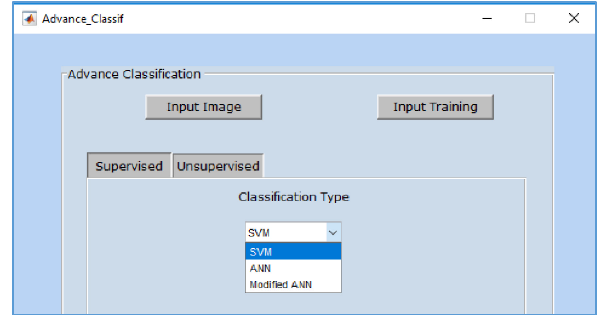
Figure 11. The interface of the advanced methods in the classification module of the HICF package.